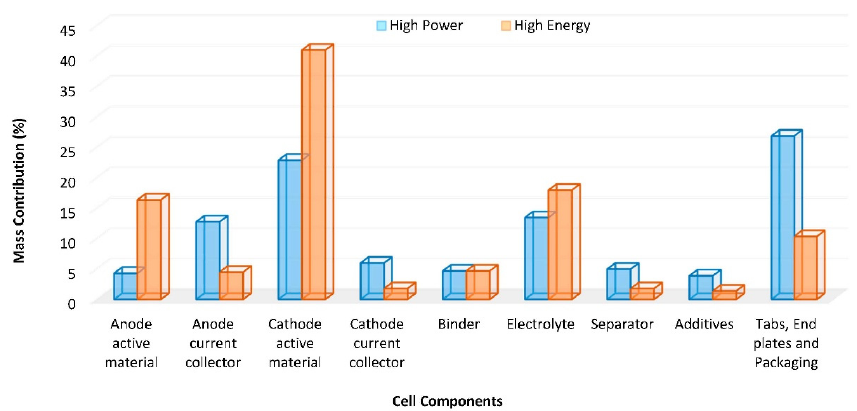
Figure 4. Comparison of mass distribution for different components of a high power and a high energy battery cell (based on data available from